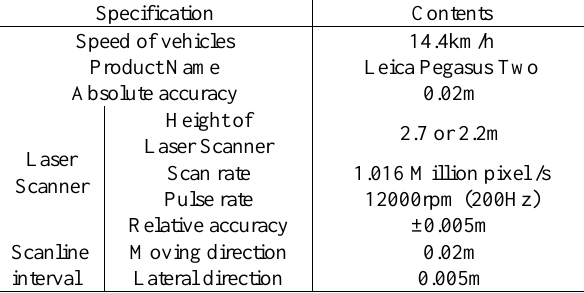
Table 1. Specification of MLS data acquisition